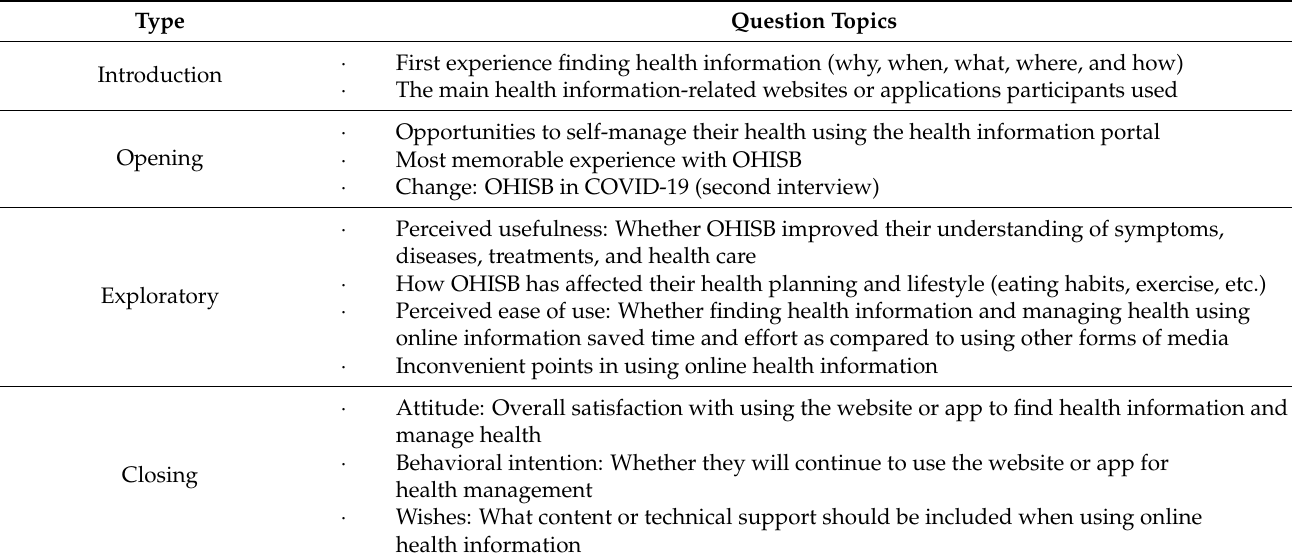
Table 1. Guiding question topics from the focus